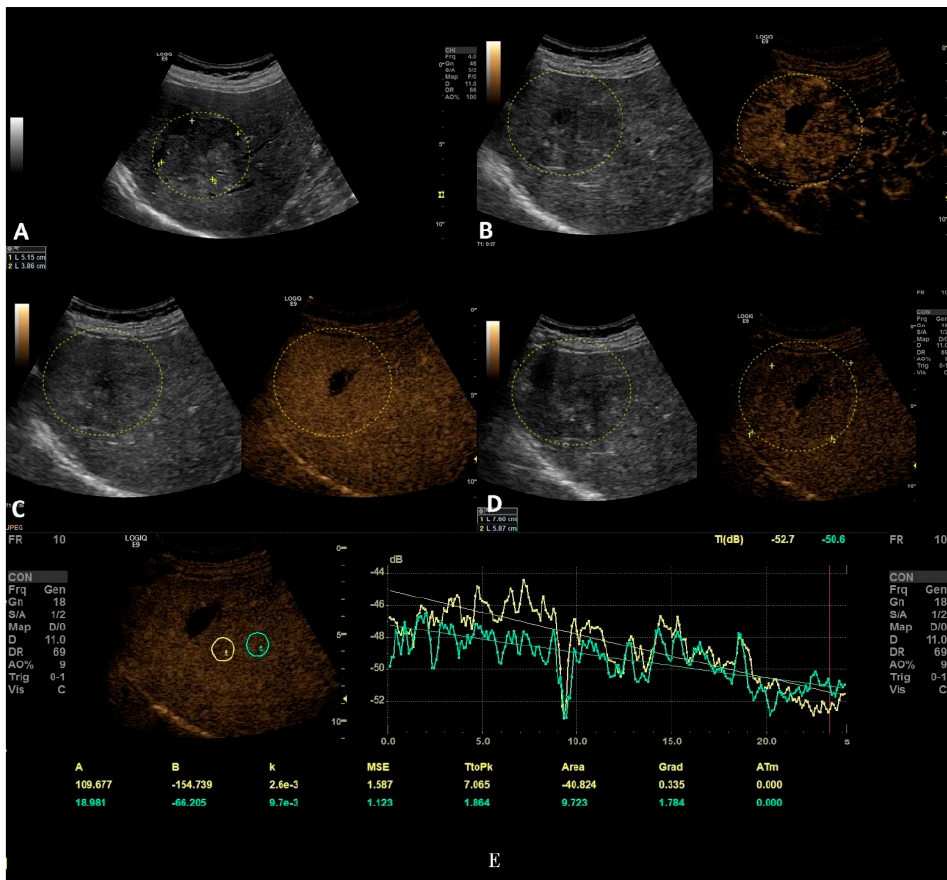
Figure 6. Arterial phase of CEUS is depicted in frame ( A ). In frame ( B ), parametric imaging was applied, thus better documenting the arrival time of bubbles by using color coding, as shown in the color-coded bar.